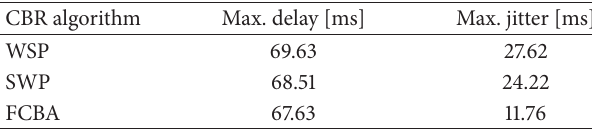
Table 8: Maximum delay and jitter